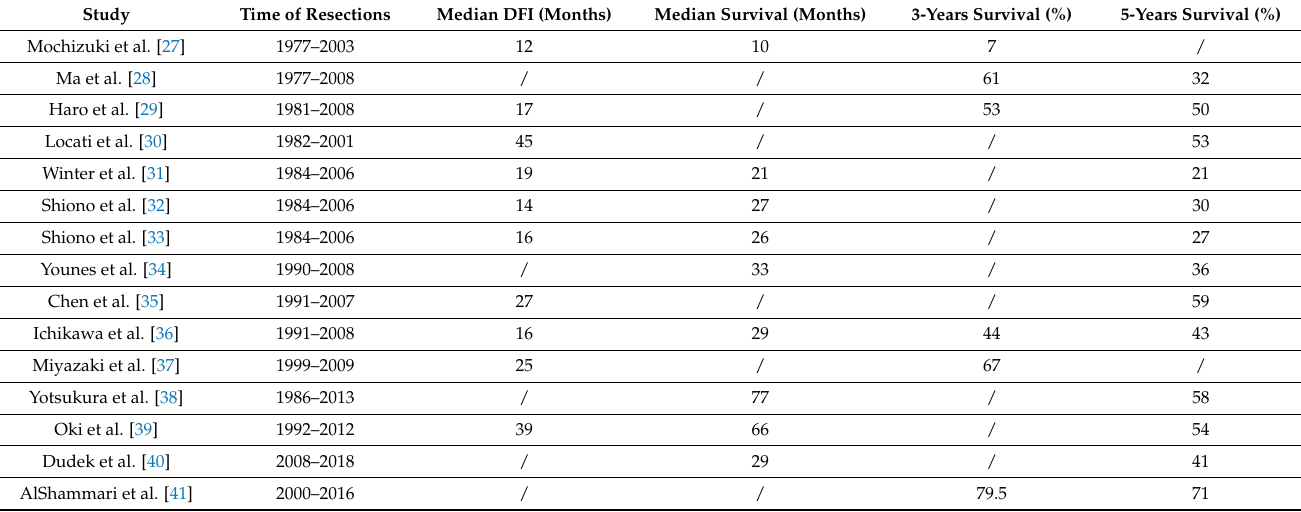
Abbreviations: DFI: disease free